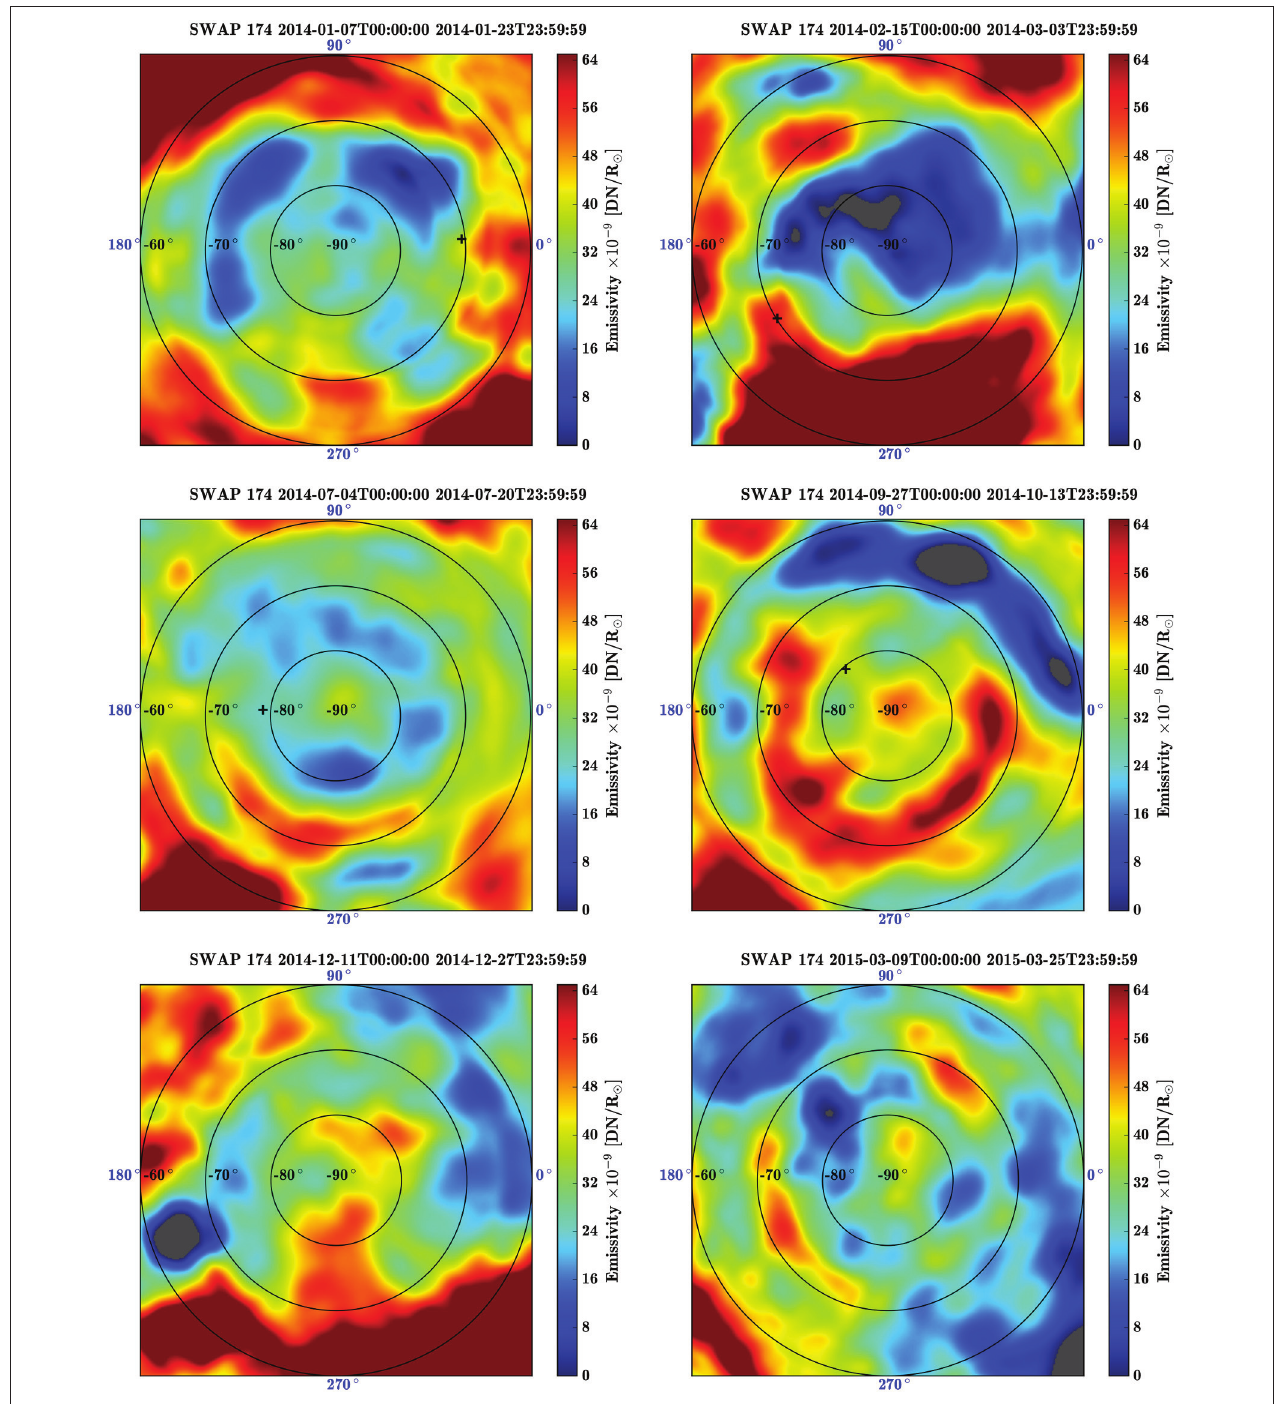
FIGURE 4 | Same as in this Figure, but for an altitude of 1.10 R ⊙ . Note that the positions of the cavity center (black plus) were measured at 1.05 R